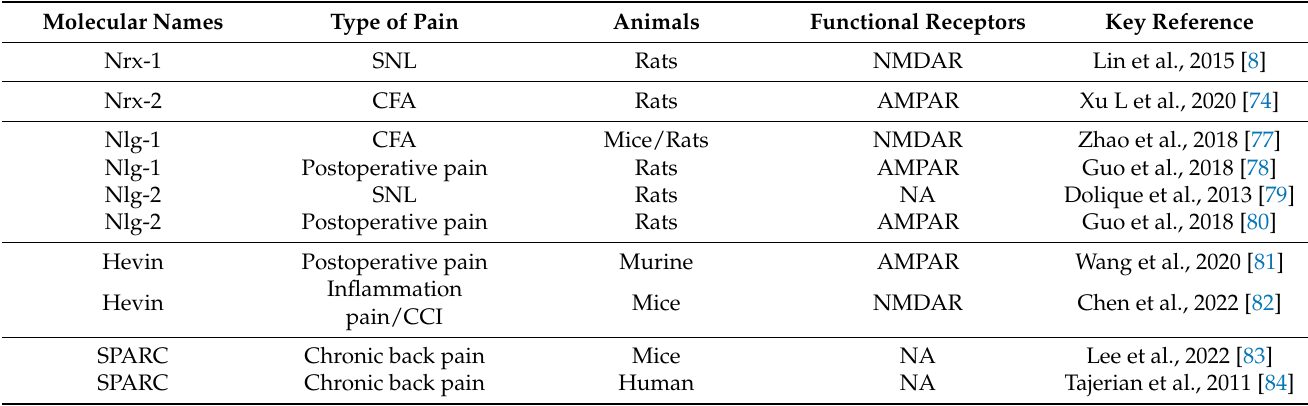
Table 1. Preclinical evidence regarding the role of trans-synaptic cell-adhesion molecules in pathologi- cal pain. CFA: complete Freund’s adjuvant, SNL: spinal nerve ligation, CCI: chronic constriction